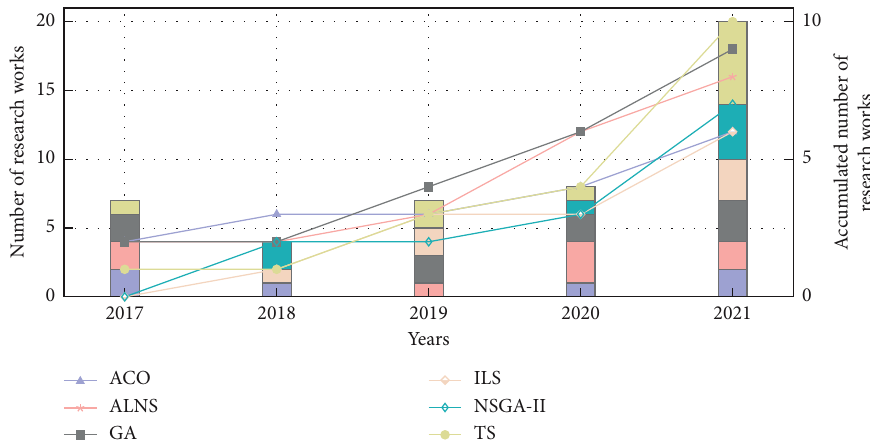
Figure 5: Number of solution methods most commonly used in the last five years. +e stacked bar chart shows the number of works per year, while the line chart shows the cumulative number of